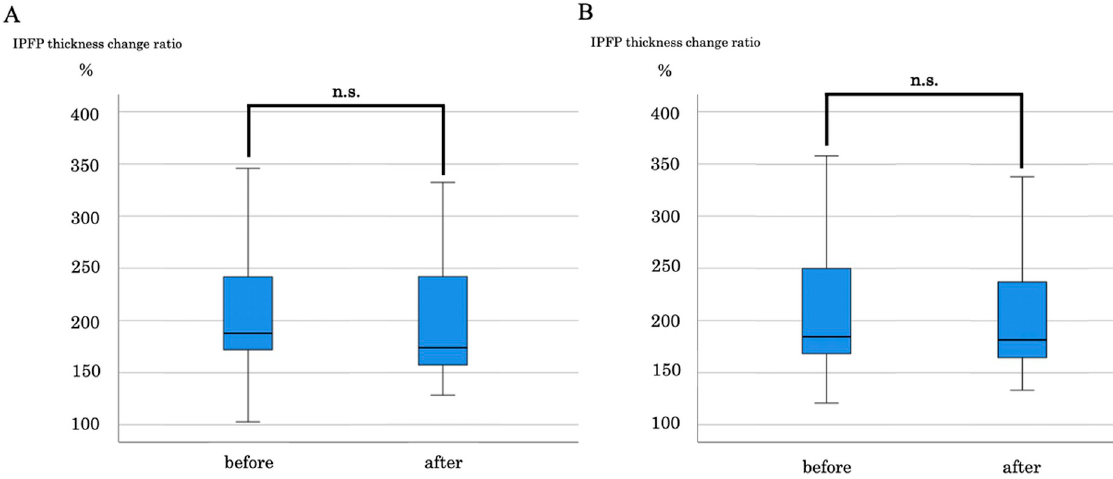
Fig 3. Respective changes before and after the two interventions. (A) Comparison of pre-and post-intervention IPFP thickness change ratio in the manual therapy group. (B) Comparison of pre-and post-intervention IPFP thickness change ratio in the hot pack group. IPFP, infrapatellar fat